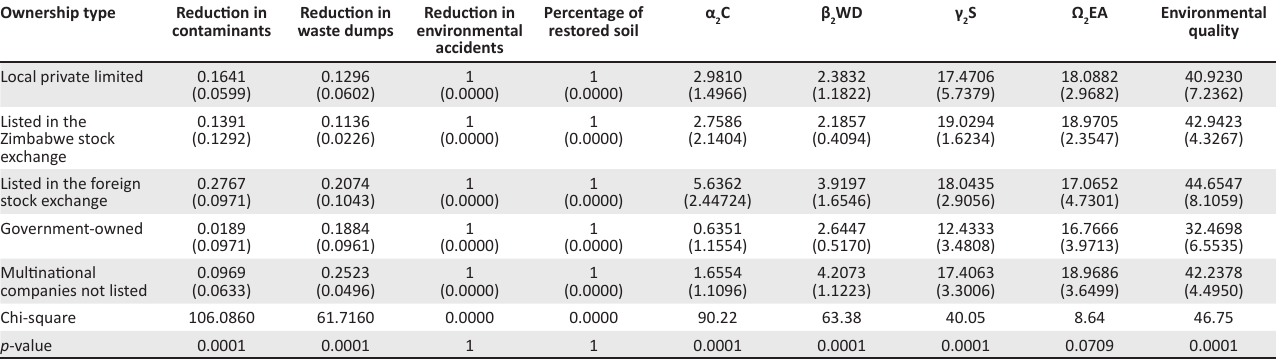
TABLE 4: Objective measures of the companies’ performance in fair fund administration. Ownership type